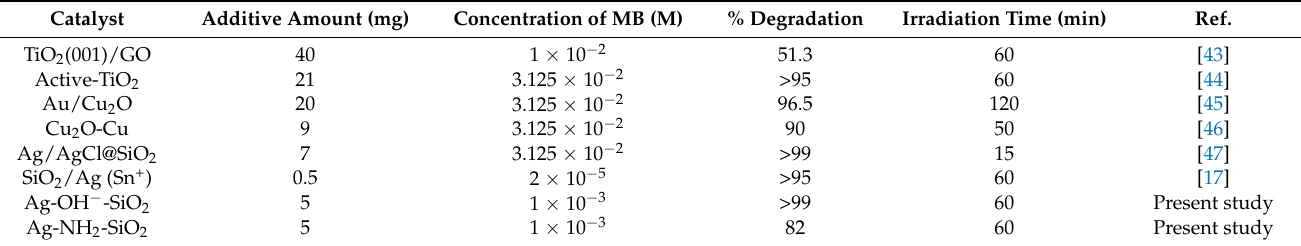
Figure 9. Degradation efficiency of MB five times in the presence of Ag-OH − -SiO 2 under visible light irradiation. (the same experimental conditions with Figure 8). Table 4. Comparison of study for MB photodegradation.